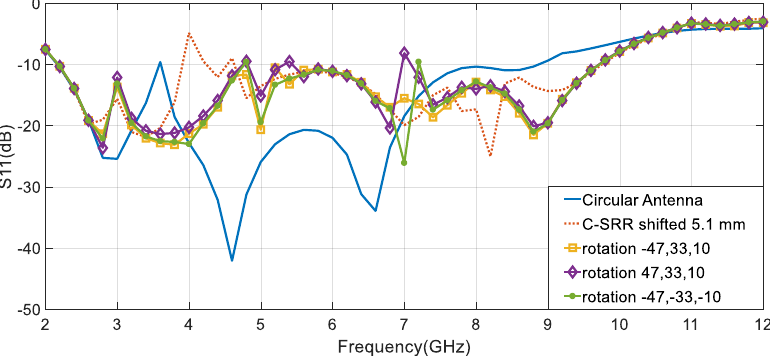
Figure 32. S 11 of C-SRRs inner ring rotation for positive and negative angles.